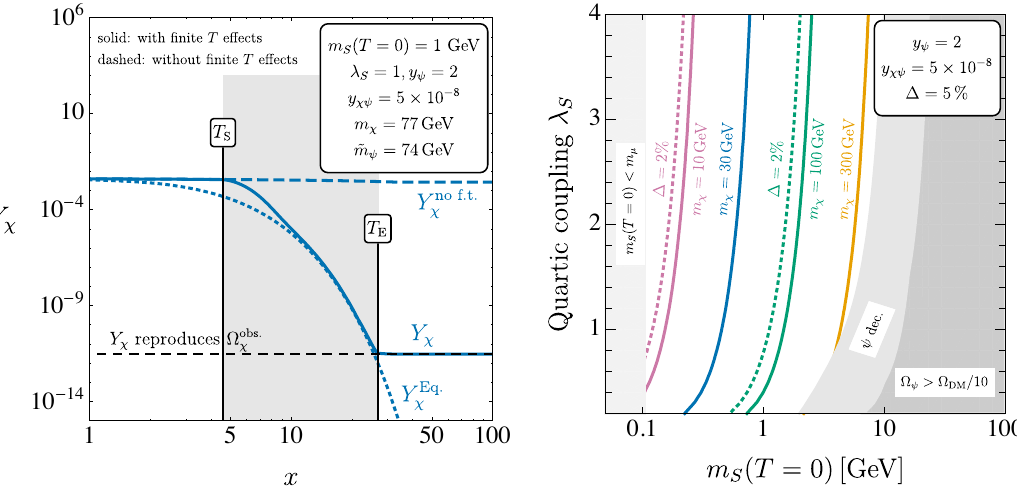
Figure 9 . Left: the evolution of the yield of (cid:31) as a function of temperature (solid) with the equilibrium yield of (cid:31) (dotted) and the yield calculated without accounting for the (cid:12)nite temperature e(cid:11)ects (dashed). Also shown is the yield which is required to obtain the observed relic abundance of (cid:31) (black, dashed). Right: the required values of m S ( T = 0) and (cid:21) S for various (cid:31) masses, for (cid:1) = 5% and 2%. In the left light-grey region S is not in equilibrium throughout the decay of (cid:31) , in the central grey region decouples before T E , while in the right dark-grey region is not a subdominant